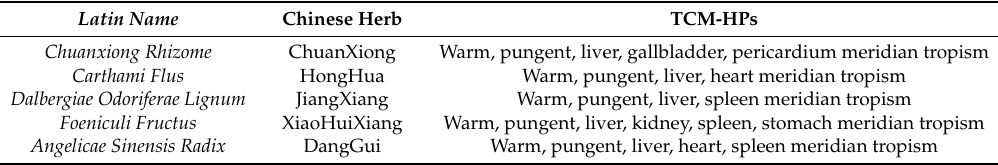
Table 5. The details of 5 pungent TCMs in this